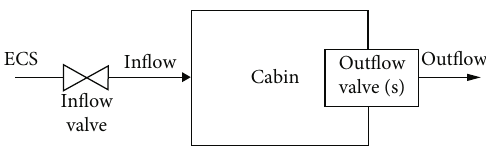
Figure 1: Diagram view of cabin